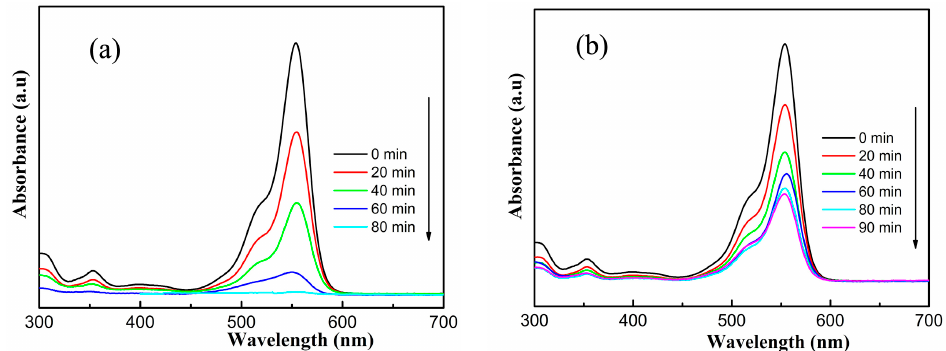
Figure 8. The variations of adsorption spectra of aqueous RhB over different phototocatalysts: ( a ) the BS-2# sample; and ( b ) Bi 2 S 3 nanorods.